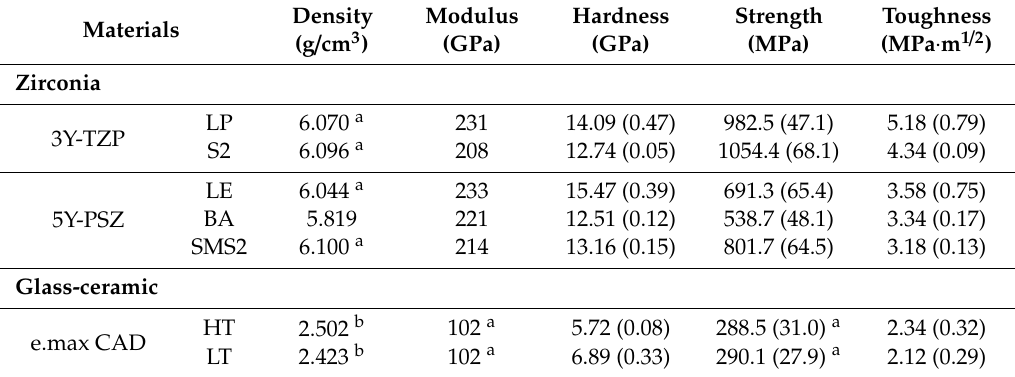
Table 3. Physical and mechanical properties of the specimens investigated. Standard deviations in parentheses.